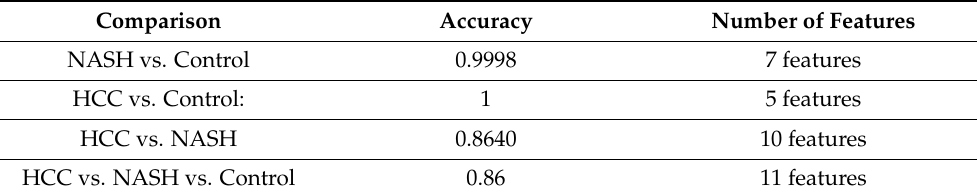
Figure 4. Machine learning-based sample classification between NASH, HCC, and controls. ( A ) shows the workflow of the software for feature selection, feature wrapping, and development of the classification algorithms. ( B ) shows display of the confusion matrix of the best-observed classifier (linear discriminant analysis.). Cross-validation ensured that the patient numbers in the confusion matrix were real and not natural numbers. The evaluation was performed by averaging a 5-fold cross-validation on 10,000 repeats. ( C ) shows the clustering of the data and their intrinsic similarity using Ward linkage and Canberra distances. Table 2. Classification accuracy for NASH, HCC, and controls. Results were obtained by the given number of features and the algorithms by averaging a 5-fold cross-validation on 10,000 repeats.